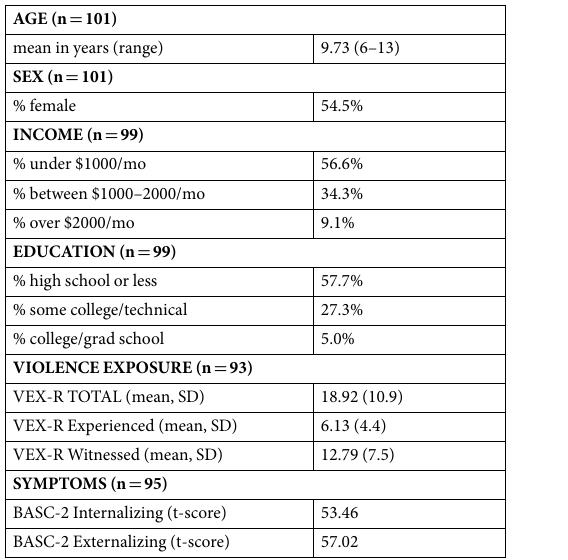
Table 1. Demographic and clinical data for the